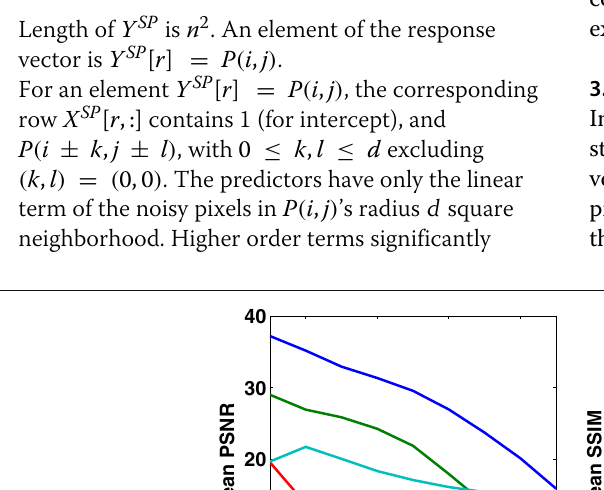
Fig. 4 Average denoised PSNR and average denoised SSIM using Median, BM3D, wavelet and regression filters for a given salt & pepper noise p ; averaging over six